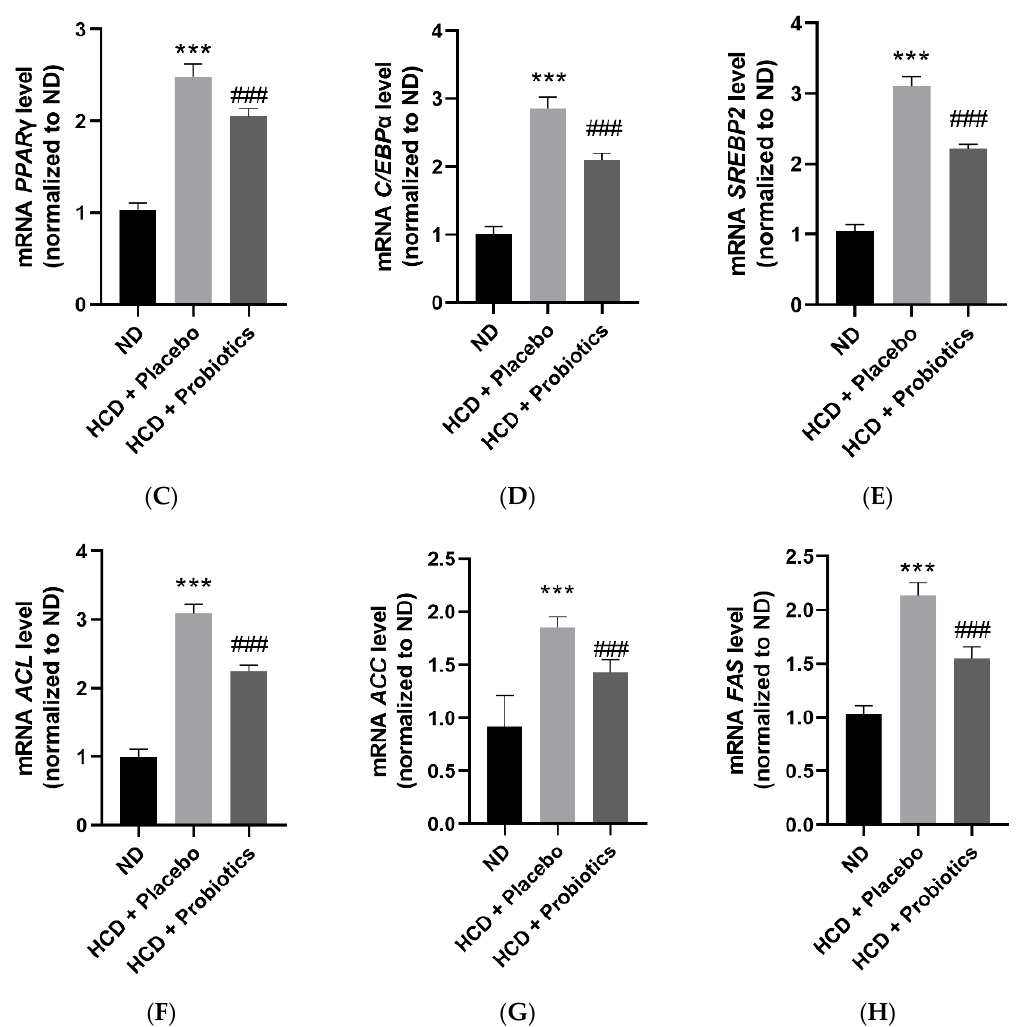
Figure 3. Effect of MSPs on adipogenesis and lipogenesis in the visceral adipose tissues of HCD-fed mice. ( A ) PCNA DAB staining of representative histological sections of visceral adipose tissues. Scale bar = 50 µm. ( B ) Number of PCNA-positive cells in visceral adipose tissues. ( C – E ) mRNA expression of adipogenesis-related genes in visceral adipose tissues. ( F – H ) mRNA expression of lipogenesis-related genes in visceral adipose tissues. Data are expressed as mean ± standard deviation ( n = 5 per group). *** p < 0.001 vs. ND; ### p < 0.001 vs. HCD + placebo. Legend: ACC, acetyl-CoA carboxylase; ACL , ATP citrate lyase; C/EBP , CCAAT/enhancer binding proteins; FAS , fatty ac-